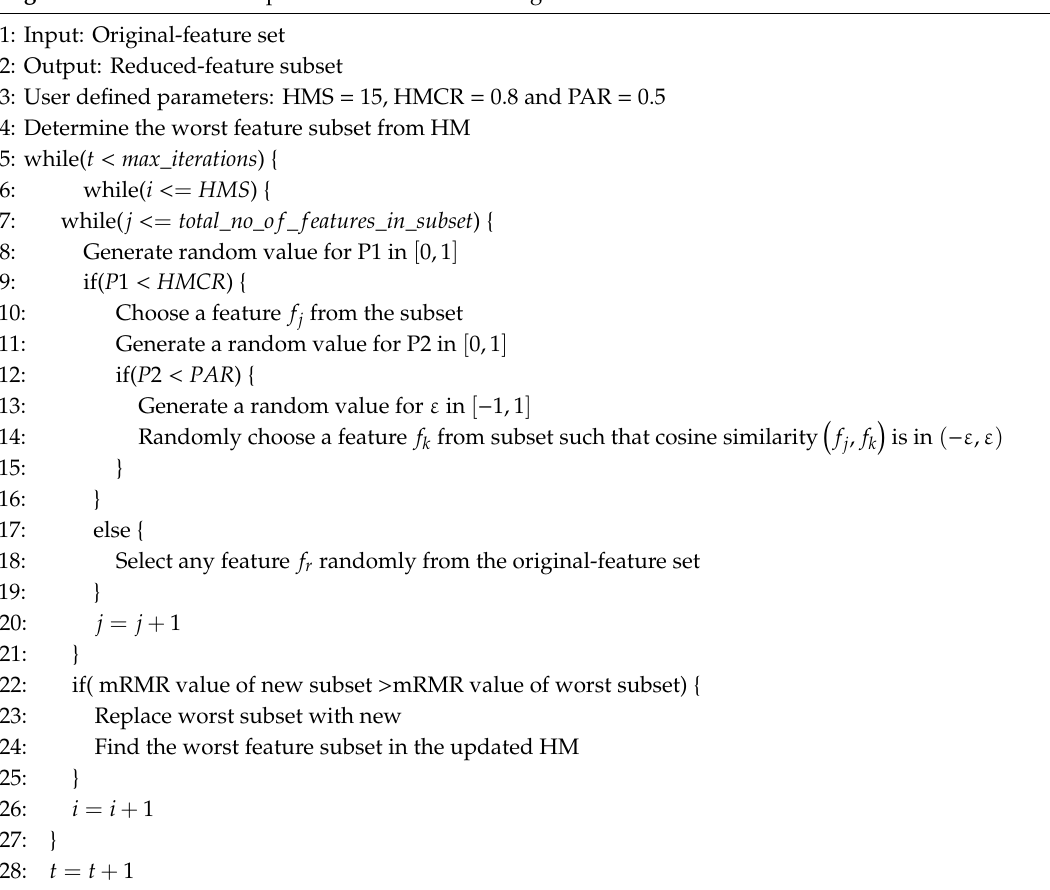
Algorithm 1 Selection of Optimal Feature Subset using